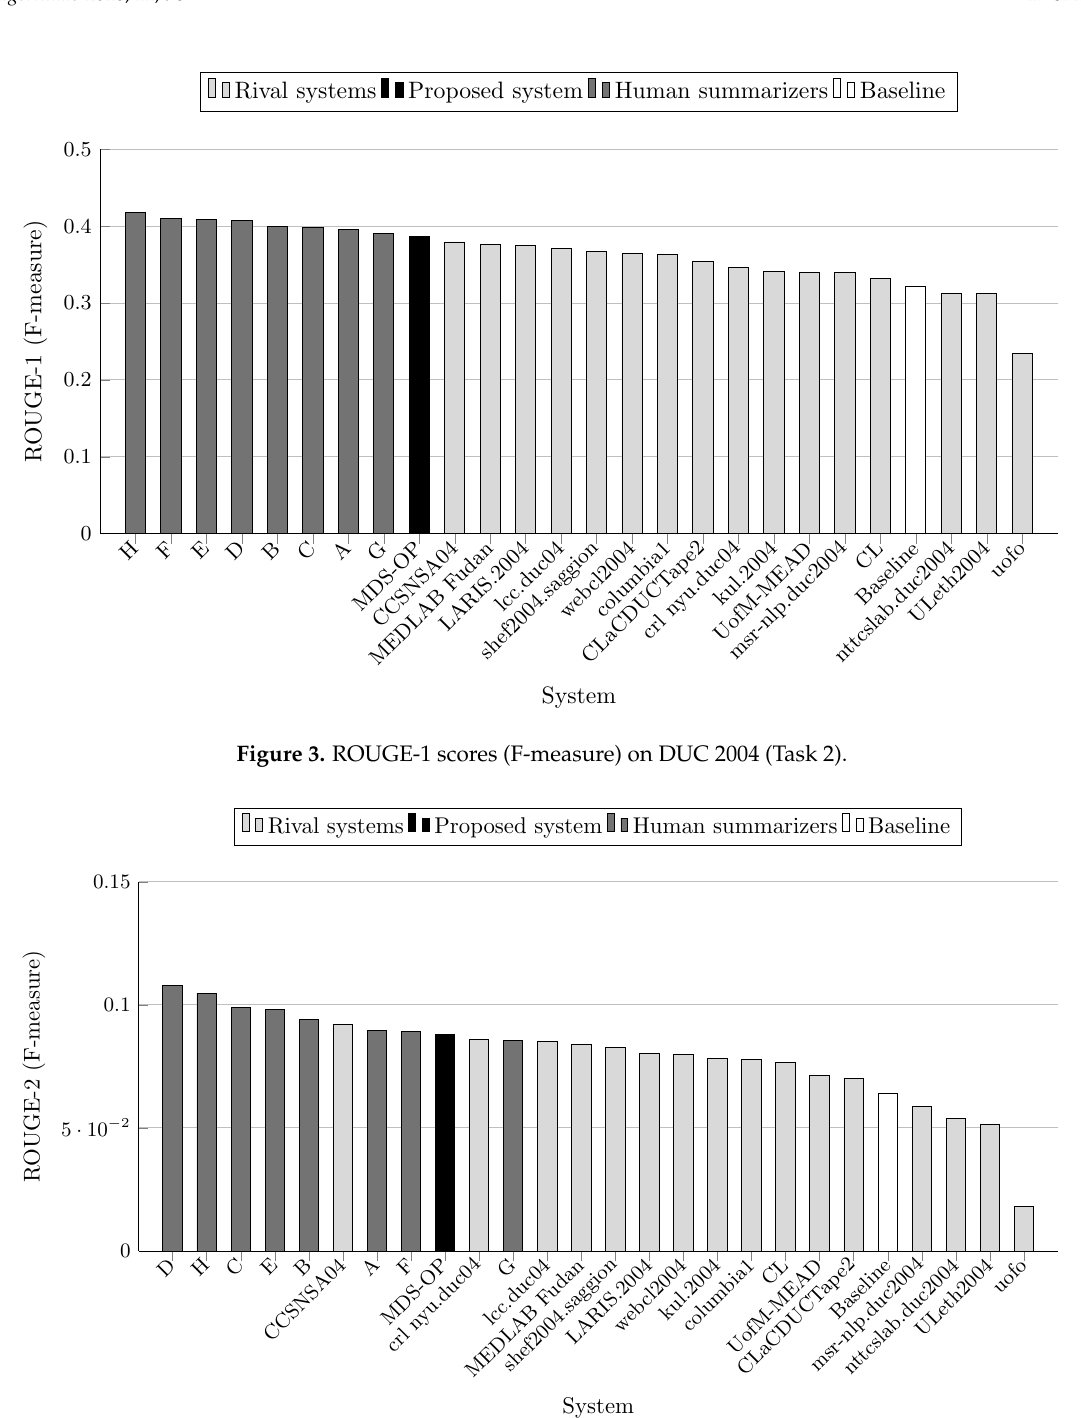
Figure 4. ROUGE-2 scores (F-measure) on DUC 2004 (Task